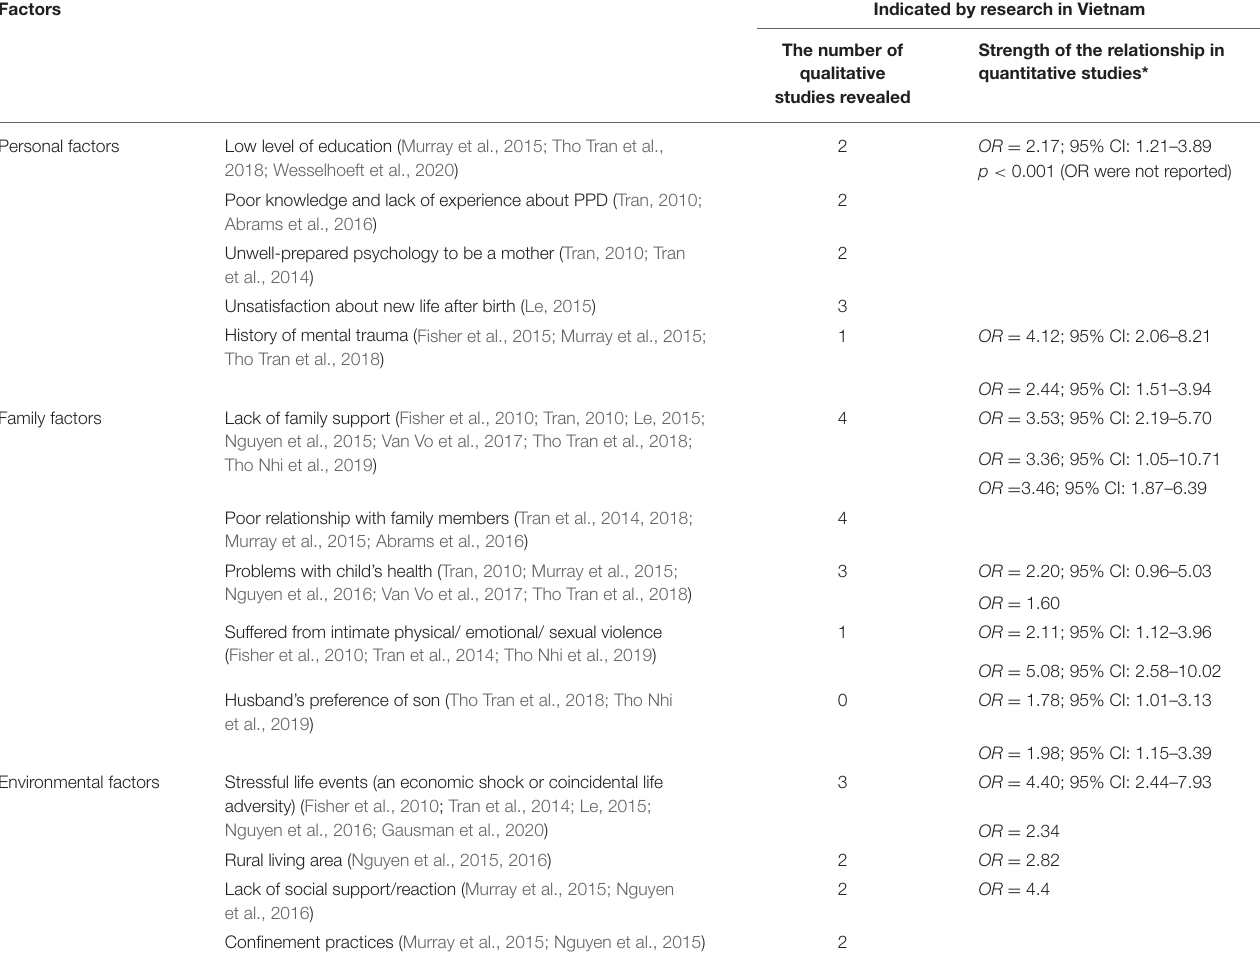
TABLE 3 | Risk factors of PPD reported by articles in Vietnam from 2010 to 2020. Factors Indicated by research in Vietnam